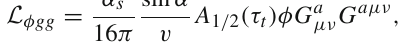
Fig. 3 The allowed region of the parameters in m Z (cid:2) - g (cid:2) plane. In the left and right panels, m φ is taken as 30 GeV and larger than m h / 2, respectively. The blue, green, red and brown lines represents the upper bound on the invisible Higgs decays. The values of sin α corresponding